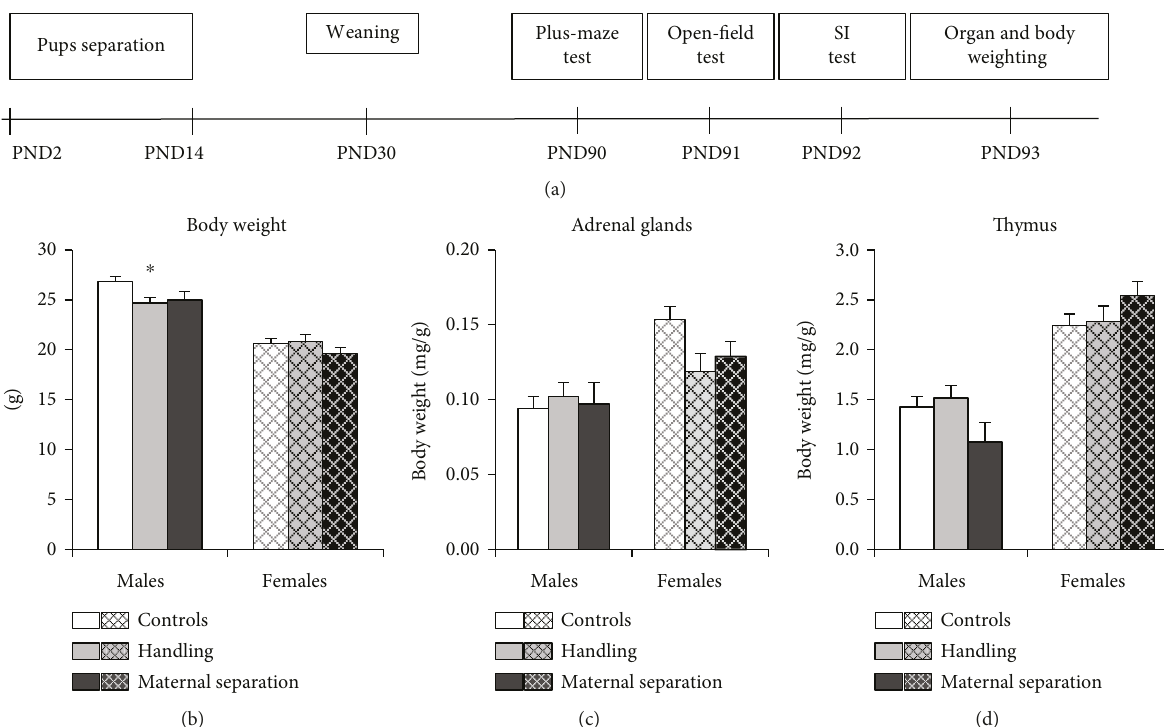
Figure 1: Timeline of the experiment (a), weights of the body (b), relative weights of adrenal glands (c), and thymus (d) in adult male and female mice. Handling decreased the weight of the body in males but not females. Females have the only tendency to reduce relative adrenal weight under early postnatal stress. Relative weights of adrenal glands and thymus are shown as organ weight in mg per gram of body weight. Data present as mean ± standard error of the mean (SEM). White box: controls (males n = 11 , females n = 11 ); grey box: HD (males n = 10 , females n = 6 ), black box: MS (males n = 6 , females n = 8 ); open columns: males; cross-hatched columns: females. ∗ p < 0 05 compared to